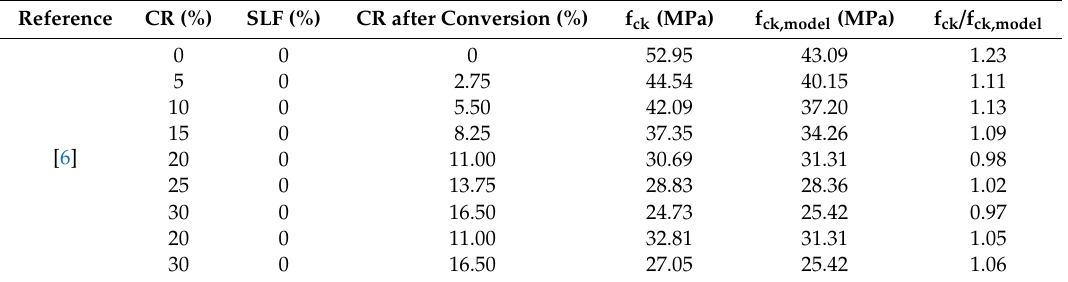
Table 12. Verification of the prediction model for the compressive strength (f ck